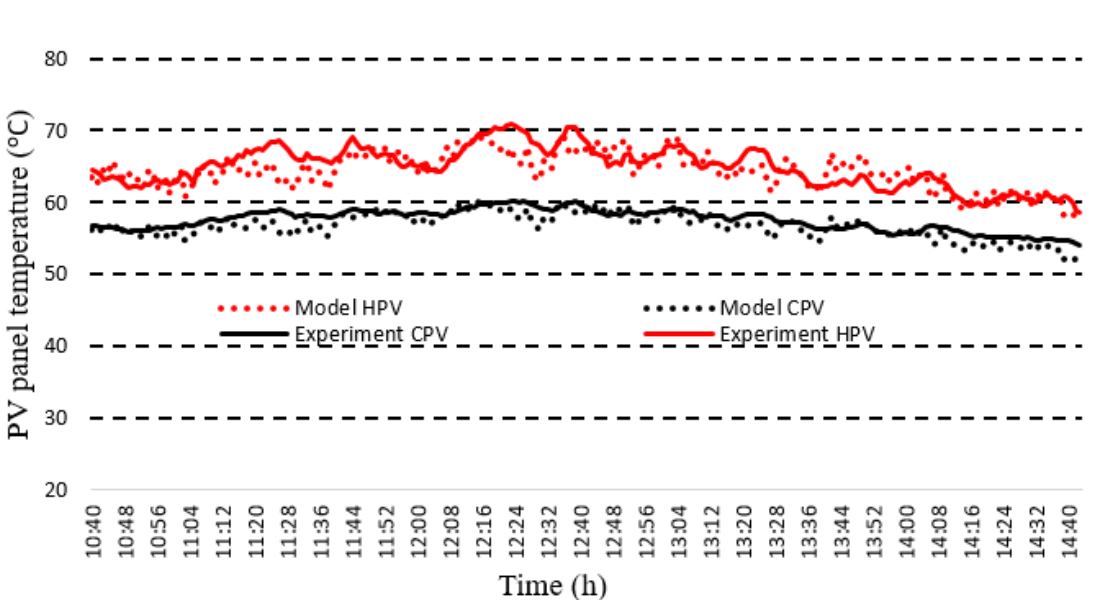
Figure 12. Experimental and simulated cooled and reference PV temperatures on 22 June at 13:50 (G = 809.412 W/m 2 , T am = 41.75 °C, T ai = 43.14 °C, T li = 24.47 °C, WS = 1.3 m/s, RH = 7.54%, 𝑚 𝑙𝑖 ̇ = 0.0054 kg/s, 𝑚 𝑎𝑖 ̇ = 0.0166 kg/s).